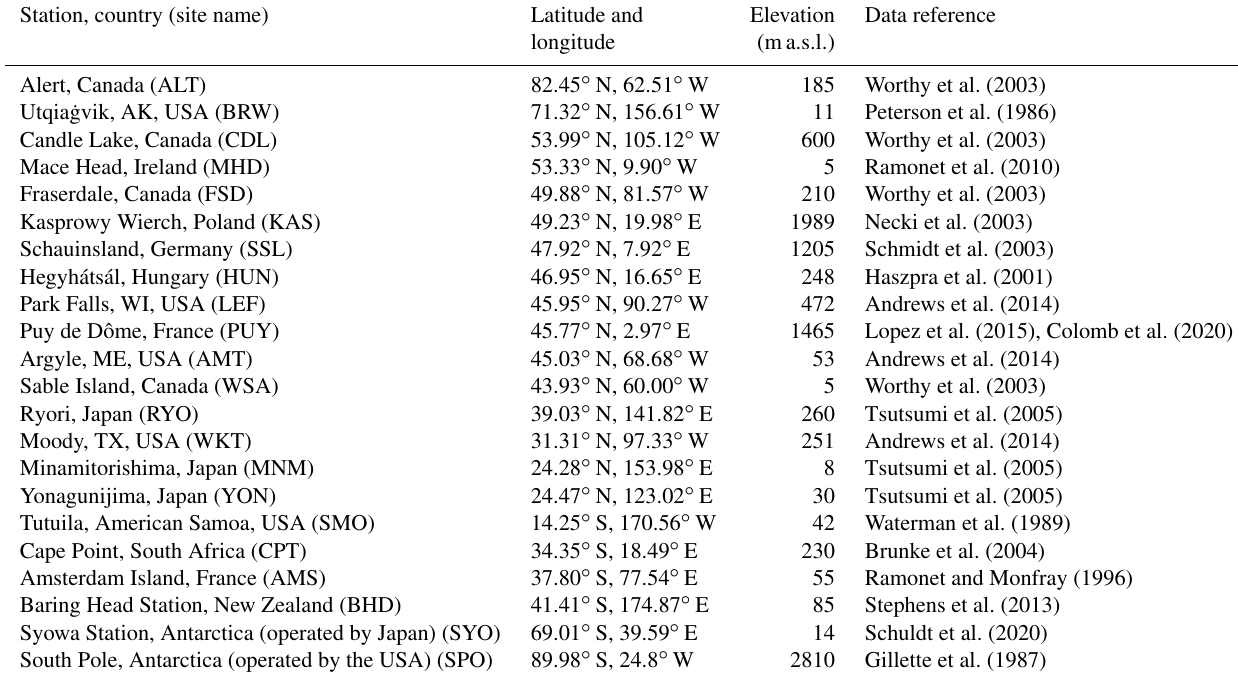
Table A1. List of stations with in situ continuous observations of CO 2 and CH 4 from GLOBALVIEWplus CO 2 ObsPack v6.0 and CH 4 ObsPack v1.0, respectively, used for the evaluation in Sect.